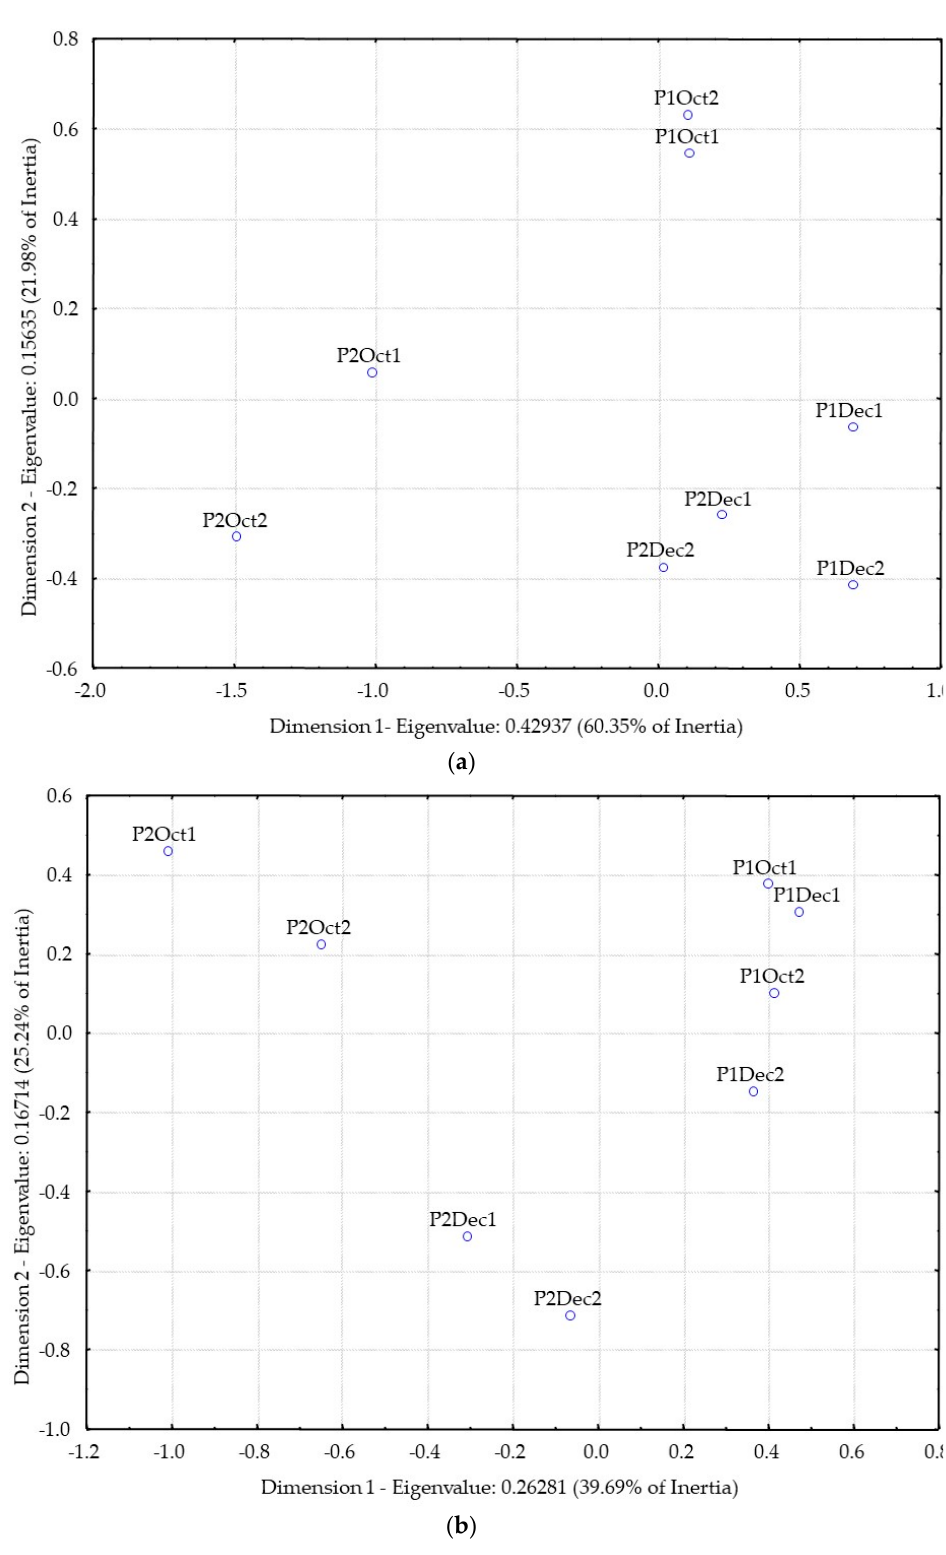
Figure 3. Distillates configuration from Correspondence Analysis applied to the odor co-occurrence matrix ( a ) and to flavor co-occurrence matrix ( b ). Replicates are identified by numbers 1 or 2 after the sample code.